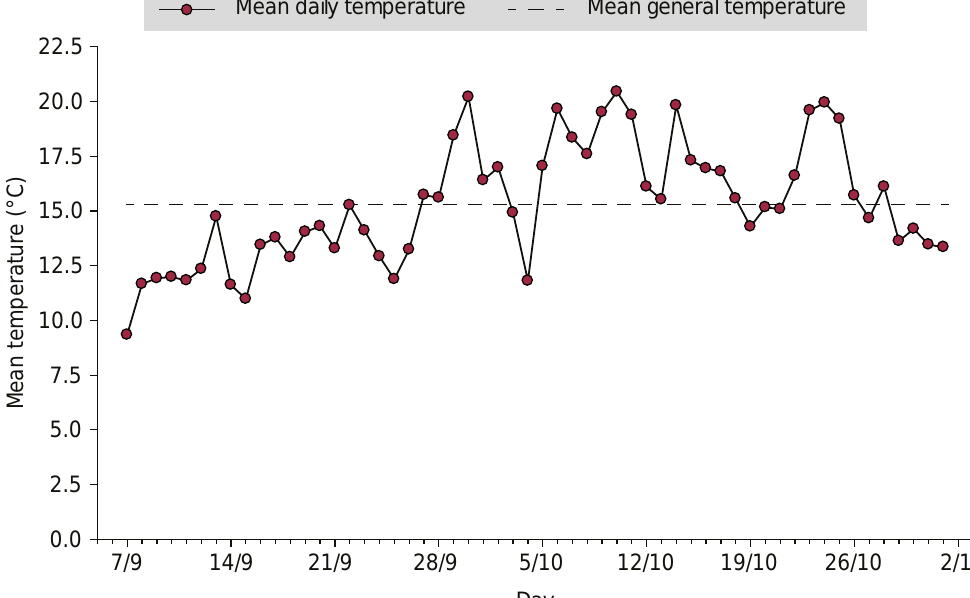
Figure 1. Mean daily temperature in Lages, southern of Brazil, during the experimental period, from 07 July 2011 to 11 January